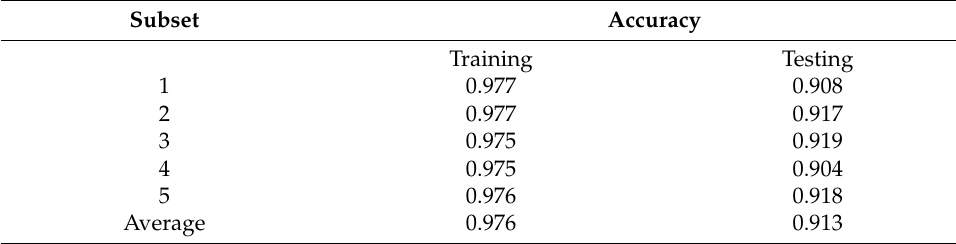
Table 4. The accuracy of five-fold cross-validation.